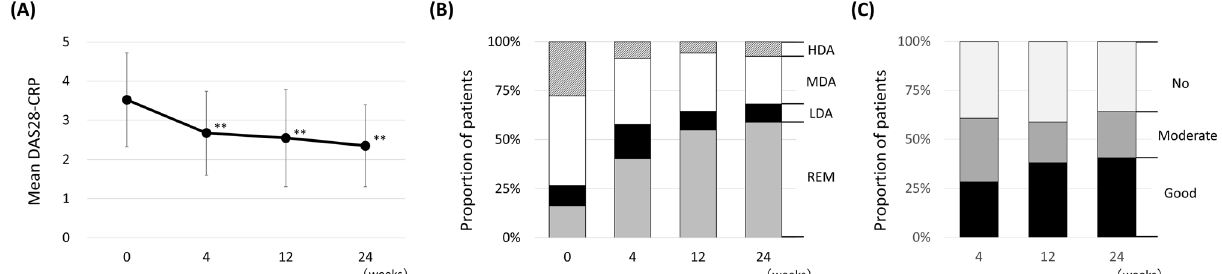
Figure 1. Overall clinical effectiveness of baricitinib for 24 weeks in rheumatoid arthritis patients. ( A ) Mean Disease Activity Score in 28 joints using C-reactive protein (DAS28-CRP) score. ( B ) Patient categorical distribution of disease activity based on DAS28-CRP score. ( C ) Distribution of the European League Against Rheumatism (EULAR) response achievement rate. **p < 0.01 in paired Student’s t test, compared to